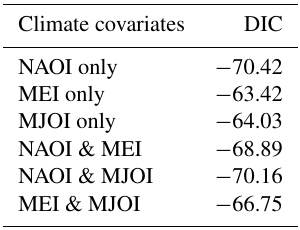
tensification rates increase by 0.08 m s − 1 h − 1 [0.052, 0.11] (95 % CI) (3.7 kt day − 1 ). This means that intensification rates